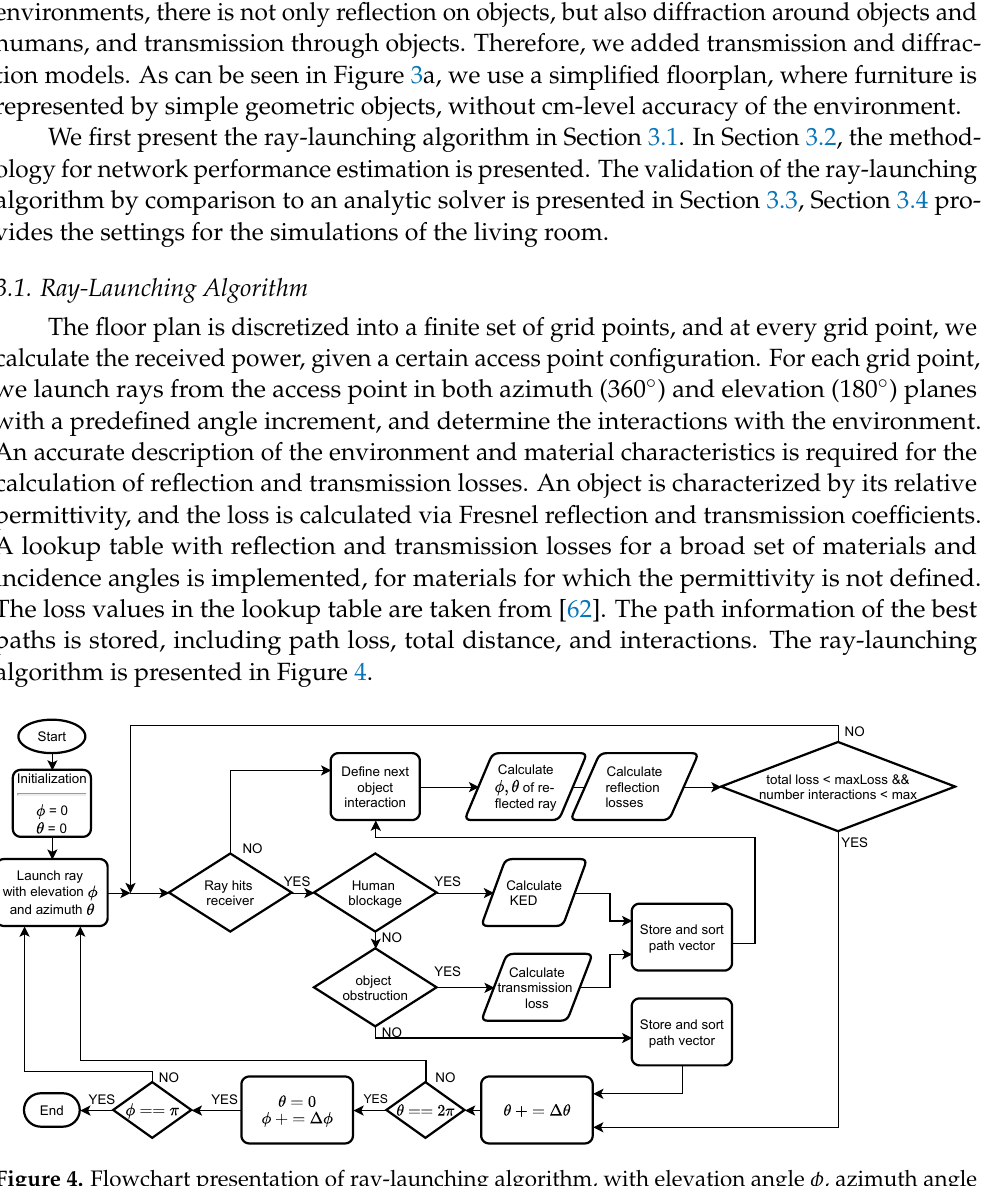
Figure 4. Flowchart presentation of ray-launching algorithm, with elevation angle φ , azimuth angle θ , and elevation and azimuth increment ∆ φ , ∆ θ